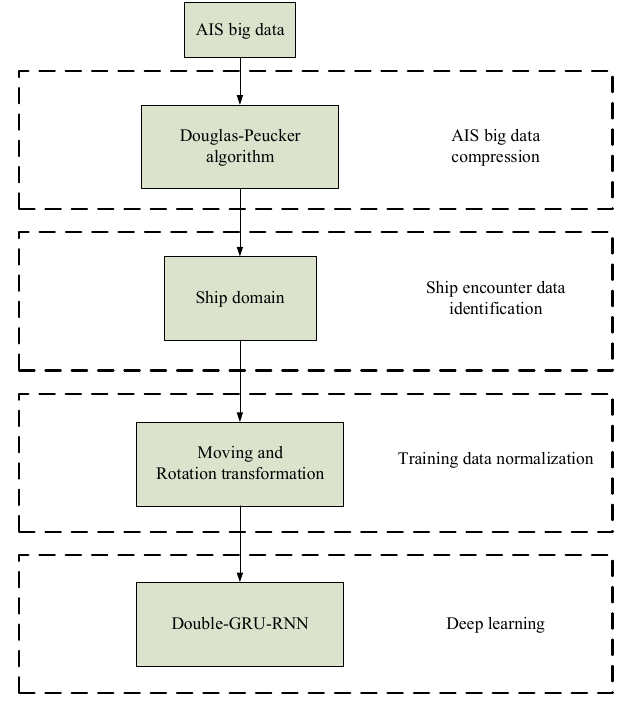
Figure 2. Framework of the proposed algorithm.